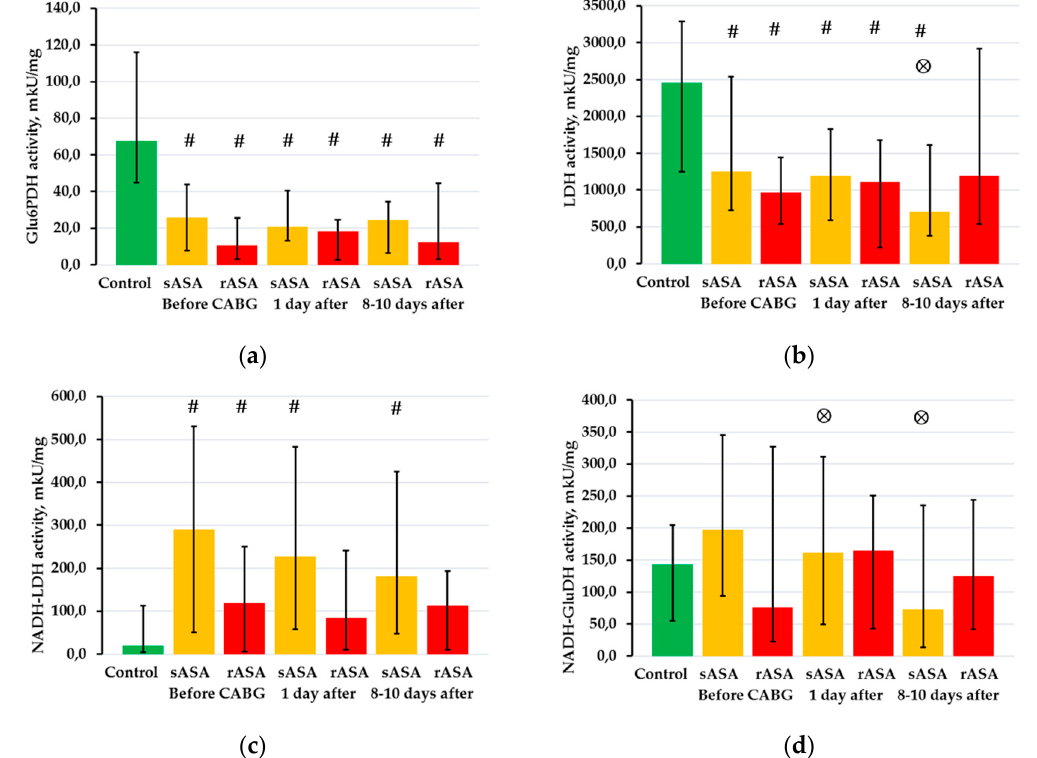
Figure 2. The activity of NAD(P)-dependent dehydrogenases in sASA and rASA patients with CHD before and after CABG. ( a ) The activity of glucose-6-phosphate dehydrogenase. ( b ) The activity of the NAD-dependent reaction of lactate dehydrogenase (aerobic reaction). ( с ) The activity of the NADH-dependent reaction of lactate dehydrogenase (anaerobic reaction). ( d ) The activity of the NADH-dependent reaction of glutamate dehydrogenase. The data represent the medians and interquartile ranges (Me (C25—C75)). # : p < 0.05 vs. control (Mann-Whitney U test), ⊗ : p < 0.05 vs. with indicators of the patients before CABG (Wilcoxon matched pairs test).